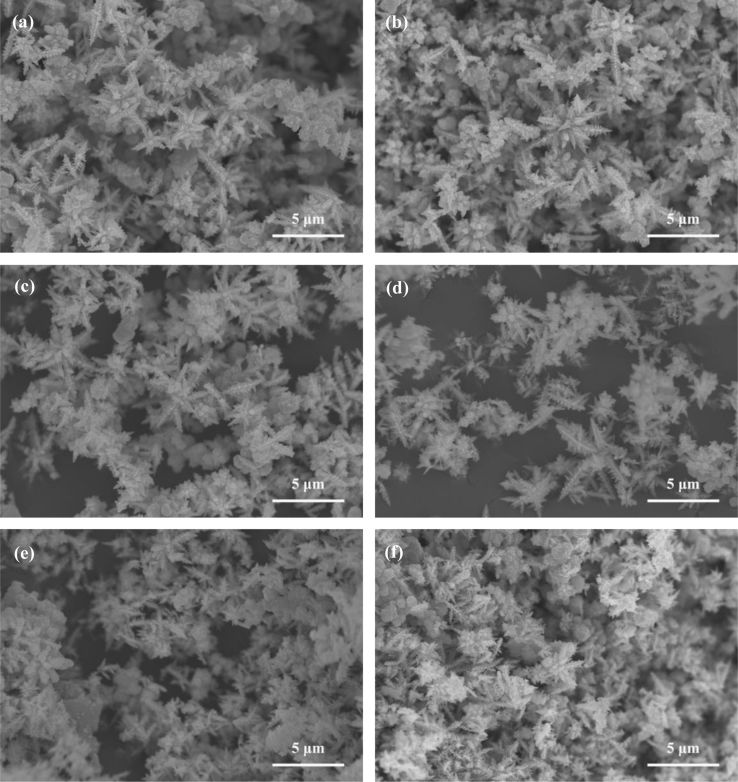
SEM images of NiS/CdS NFs HSNCs prepared with a constant Ni/Cd FMR of 0.6 and different amounts of NaH2PO2·H2O: (a) 0, (b) 0.4, (c) 0.6, (d) 0.8, (e) 1.0 and (f) 1.2 mmol, while the amount of Cd(NO3)2·4H2O was fixed at 1 mmol (also see Table 1).